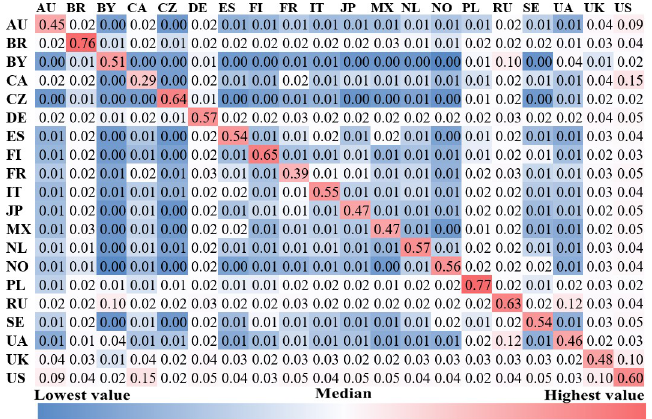
Fig 8. The density of friendship connections among countries.